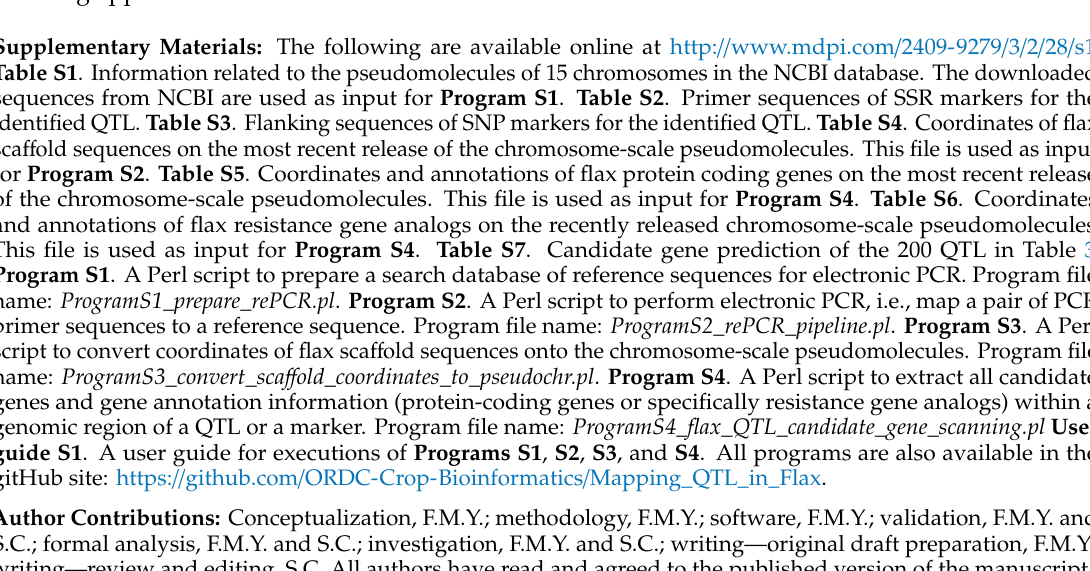
Table S1 . Information related to the pseudomolecules of 15 chromosomes in the NCBI database. The downloaded sequences from NCBI are used as input for Program S1 . Table S2 . Primer sequences of SSR markers for the identified QTL. Table S3 . Flanking sequences of SNP markers for the identified QTL. Table S4 . Coordinates of flax sca ff old sequences on the most recent release of the chromosome-scale pseudomolecules. This file is used as input for Program S2 . Table S5 . Coordinates and annotations of flax protein coding genes on the most recent release of the chromosome-scale pseudomolecules. This file is used as input for Program S4 . Table S6 . Coordinates and annotations of flax resistance gene analogs on the recently released chromosome-scale pseudomolecules. This file is used as input for Program S4 . Table S7 . Candidate gene prediction of the 200 QTL in Table